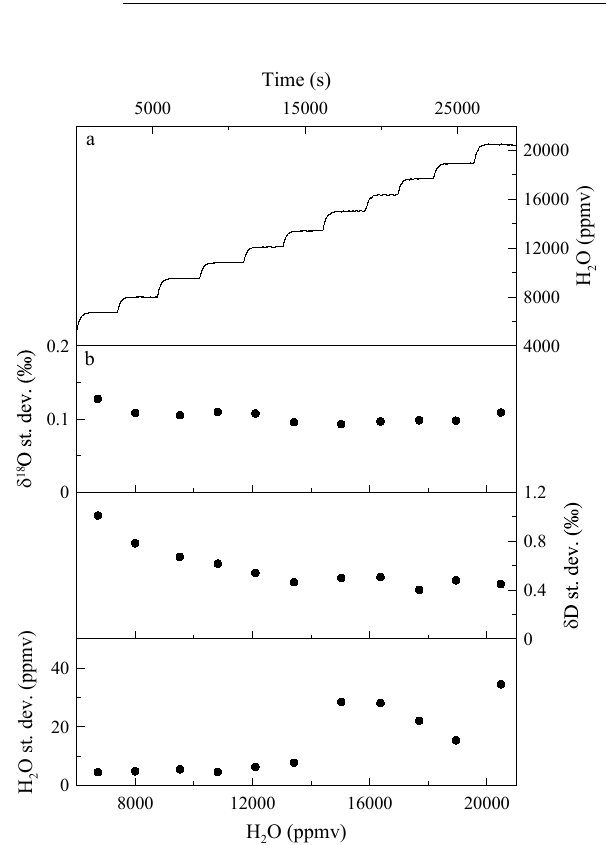
Figure 4. δ 18 O and δD reproducibility with changing water vapour amounts. (a) Water vapour mixing ratios were increased by chang- ing the speed of the pump in steps of 0.2% from 1 to 3% of its ca- pacity. (b) Evolution of the standard deviation of the water vapour isotopic measurement for δD and δ 18 O and water vapour amount as a function of the water vapour amount.